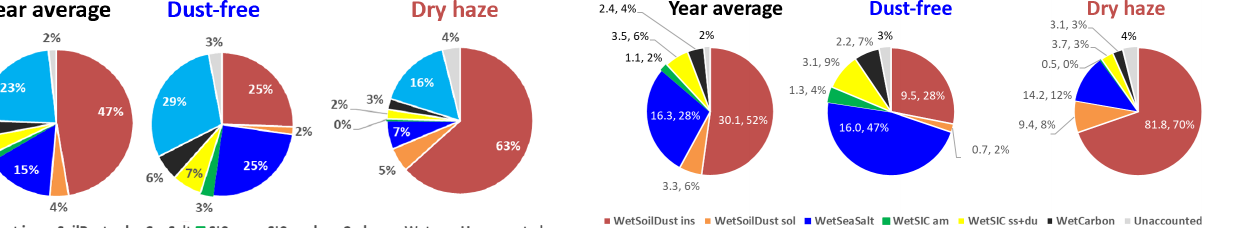
Figure 4. Inclusion of estimated water in the IMB for the total sam- pling campaign and for the dust-free and dry-haze seasons.